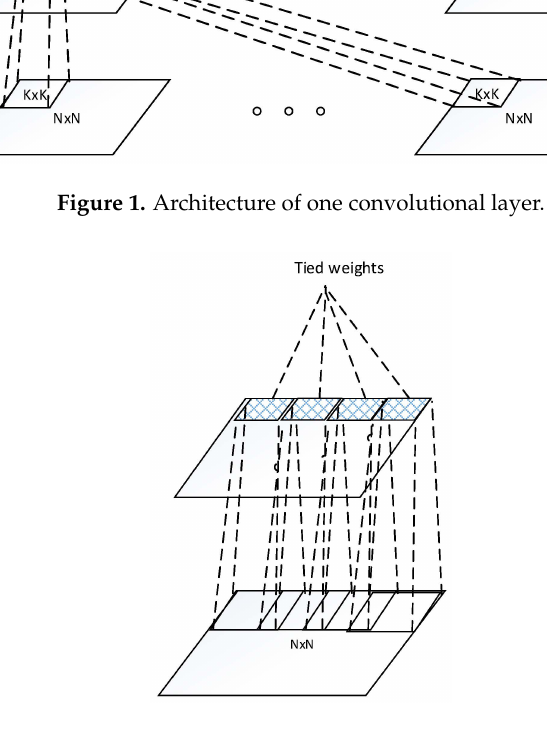
Figure 2. Tied weights within a feature map of a convolutional